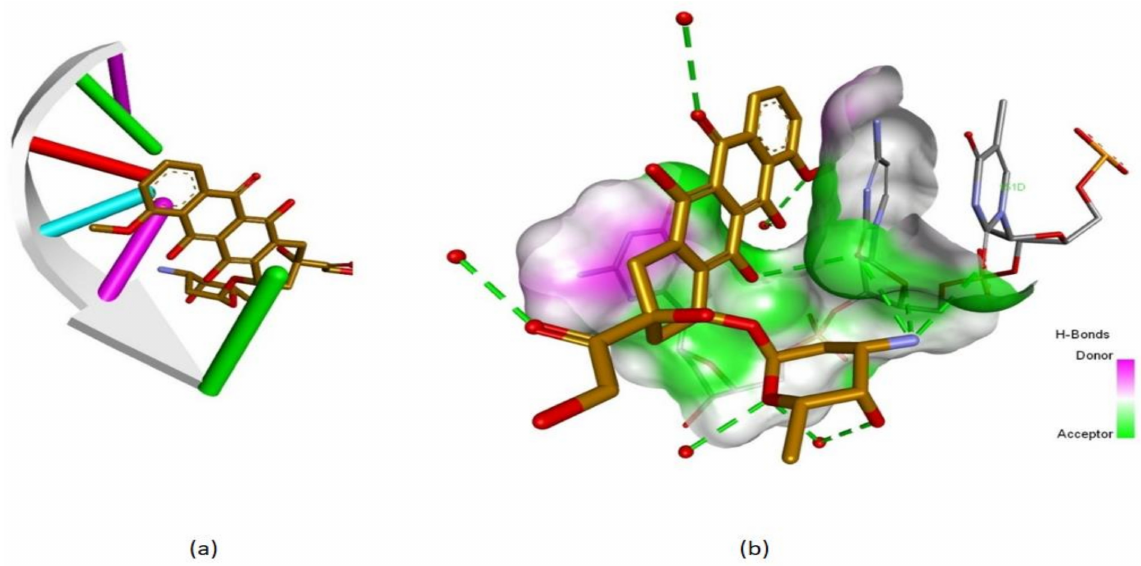
Figure 2. ( a ) Crystallographic 3D structure of doxorubicin (gold) in complex with DNA (PDB ID: 151D), d(CGATCG) and ( b ) the anthracycline structure is strongly bound to DNA base pairs through multiple hydrogen bonds (HBs) depicted as green dotted lines; DNA-ligand representation was achieved using Biovia Discovery Studio 4.1 (Dassault